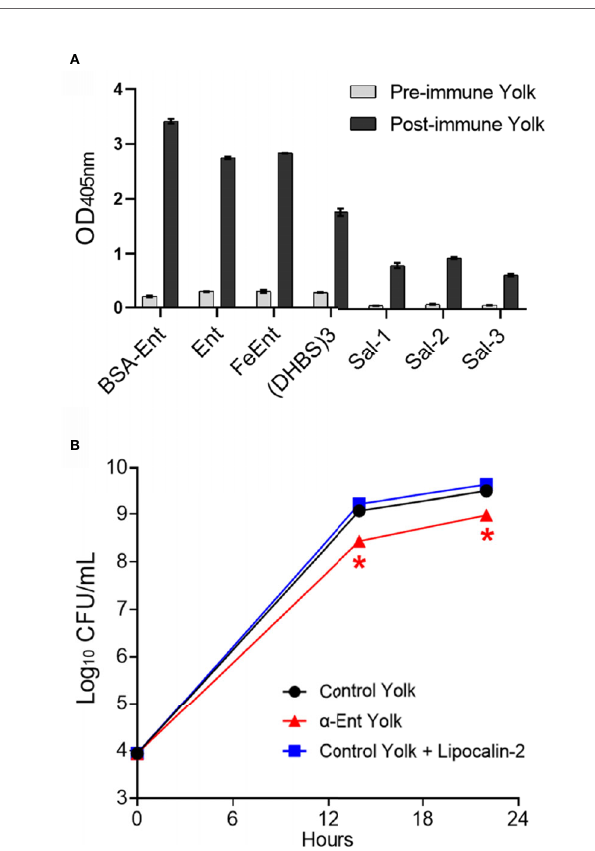
FIGURE 7 | Characterization of anti-Ent egg yolk IgY. (A) Binding of anti-Ent egg yolk IgY to different Ent derivatives. Pre-immune and post-immune egg yolk antibodies were diluted by 128-fold and served as the primary antibody in indirect ELISA. BSA-Ent, BSA-Ent conjugate; Ent, apo Ent; FeEnt, ferric Ent complex; (DHBS) 3 , linearized Ent; Sal-1, monoglucosyl-Ent; Sal-2, diglucosyl- Ent; Sal-3, triglucosyl-Ent. Error bars represent the standard deviations from at least two independent experiments with duplicate measurements performed in each independent experiment. (B) Inhibitory effect of Ent-speci fi c egg yolk antibodies on the growth of E coli under iron-restricted condition. The E coli MG1655 cells were grown in RPMI medium supplemented with control egg yolk (pre-immune yolk), anti-Ent egg yolk, or the control egg yolk containing human lipocalin-2 ( fi nal concentration of 37 µg/mL). At 0, 14 and 22 hours post-inoculation, 20 m L of culture was taken from each well, serially diluted and plated onto LB plates to enumerate CFUs. Each data point represents mean CFU ± standard deviation obtained from duplicate wells in the microtiter plate growth assay. Error bars at different time points are too small to be visualized. Asterisk symbol indicates the signi fi cant difference ( P <0.05) between the control yolk and anti-Ent yolk